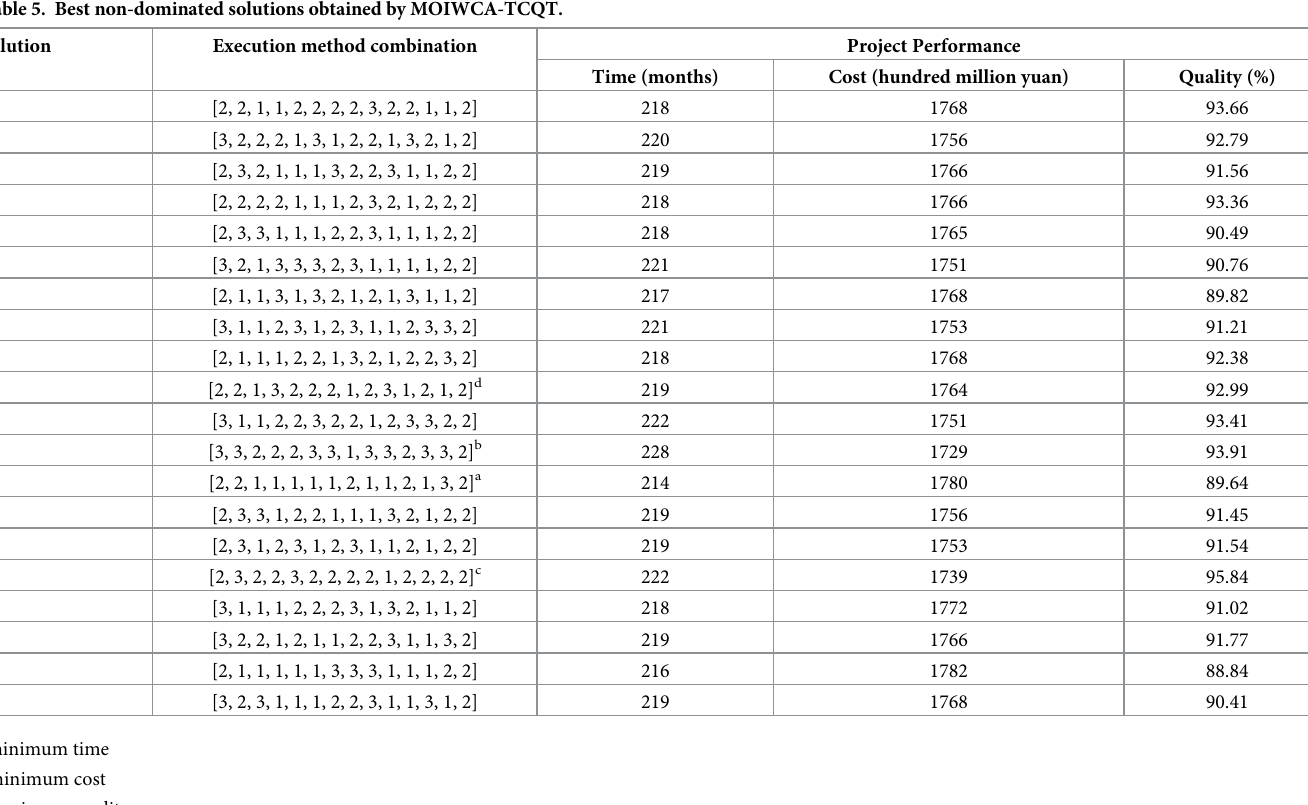
Table 5. Best non-dominated solutions obtained by MOIWCA-TCQT.